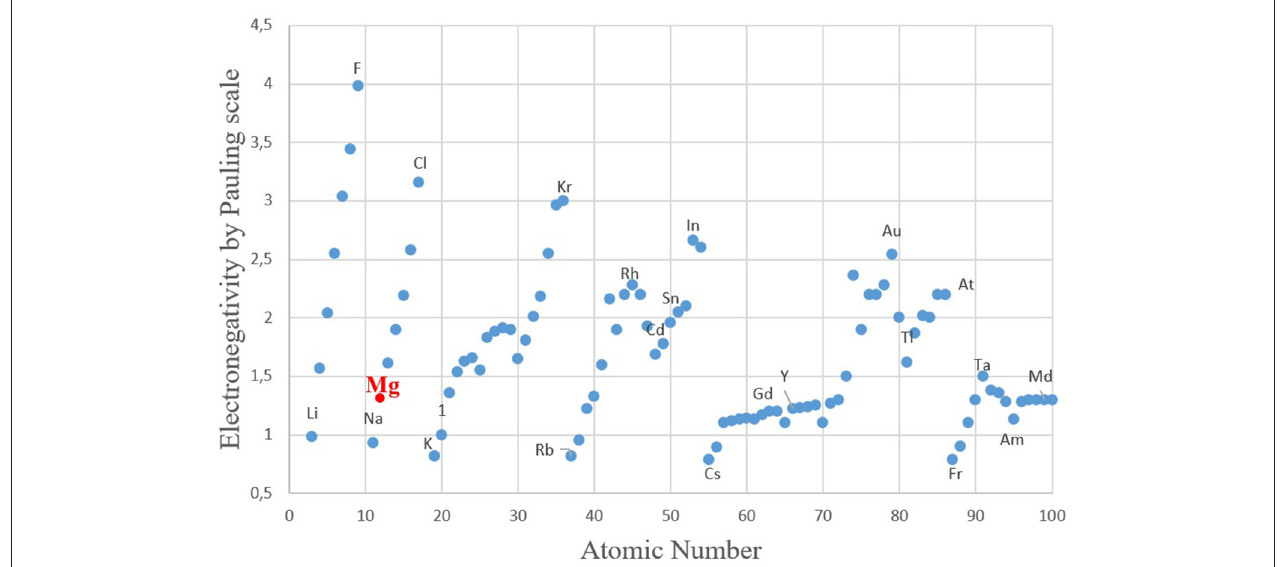
FIGURE 4 | The relationship between the Pauling scale electronegativity values with atomic numbers (data set from: https://en.wikipedia.org/wiki/Electronegativities_ of_the_elements_(data_page) with reference to: L. Pauling, The Chemical Bond , Cornell University Press, Ithaca, New York,